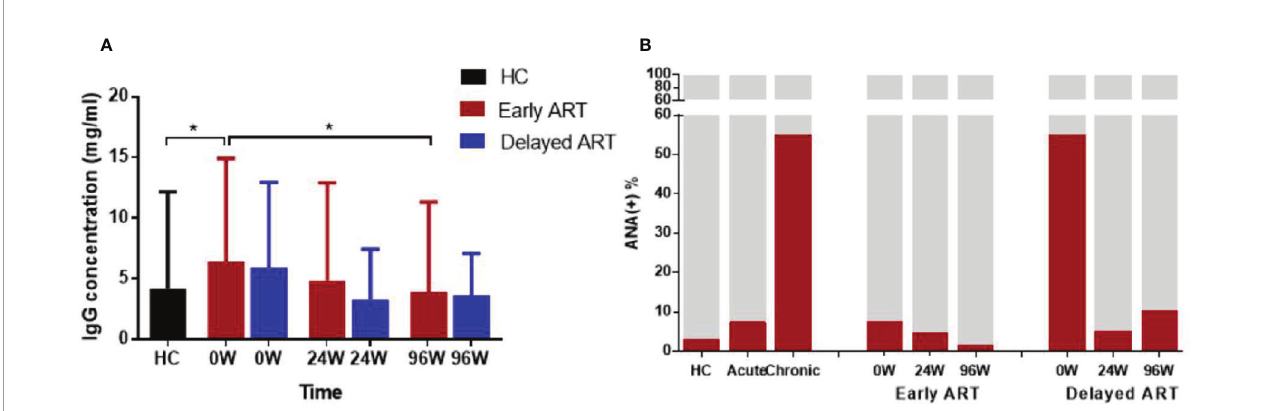
FIGURE 4 | Dynamic Changes of Total IgG and ANA in AHI Individuals After Early and Delayed ART. Plasma total IgG levels (A) and ANA positive rate (B) in healthy controls (n = 40) and AHI individuals (n = 90) after early and delayed ART. One-way ANOVA tests with P < 0.05 considered signi fi cant. * P